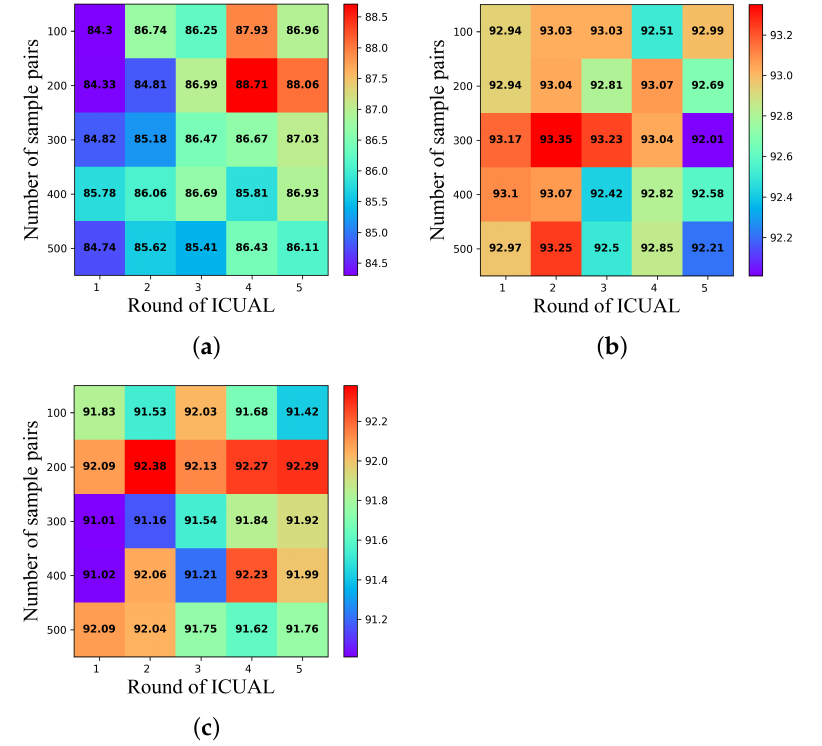
Figure 9. The impact of different ICUAL rounds and number of sample pairs on OA (after the first AUAL iteration). ( a ) PaviaU, ( b ) Salinas, ( c )